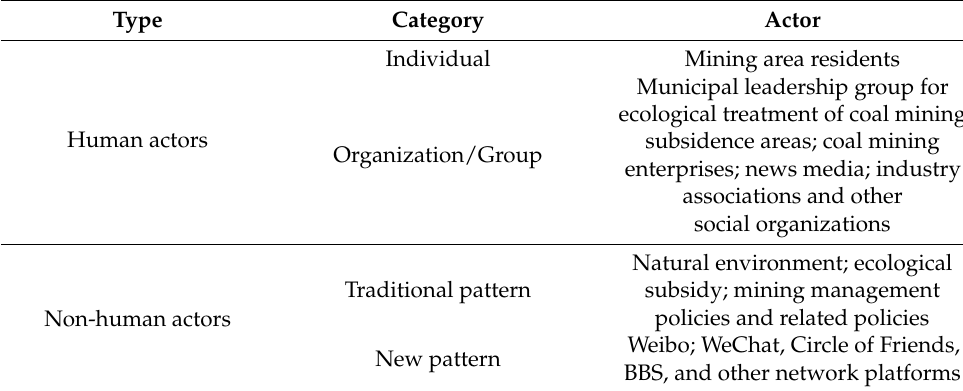
Table 1. Actors of the ecological restoration actor network.